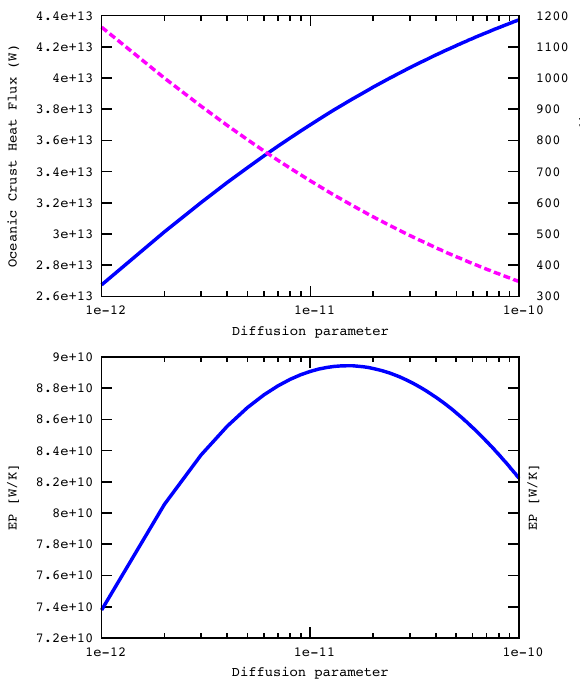
Fig. 9. Uplift and erosion: a simple model of the mass balance of continental crust driven by uplift and erosion. Weathering and erosion processes transfer continental crust material to the ocean where it is deposited as sediment. This flux of mass from conti- nental crust to sediments is denoted with J ( m ) cs . Continental crust material moves back to the continent though the process of sub- duction. This flux of mass from sediments to continental crust is denoted with J ( m ) sc . The horizontal, black dashed line denotes the ‘zero line’ which marks the surface of a hypothetical Earth with no continental crust. 1z c , 1 denotes the thickness of continental crust above, 1z c , 2 denotes the thickness of continental crust below the zero line. 1z c , 1 + 1z c , 2 = 1z the total thickness of continental crust. 1z s denotes the thickness of sediments on the ocean floor. f c and f o denotes the proportional coverage of continental crust and oceanic crust